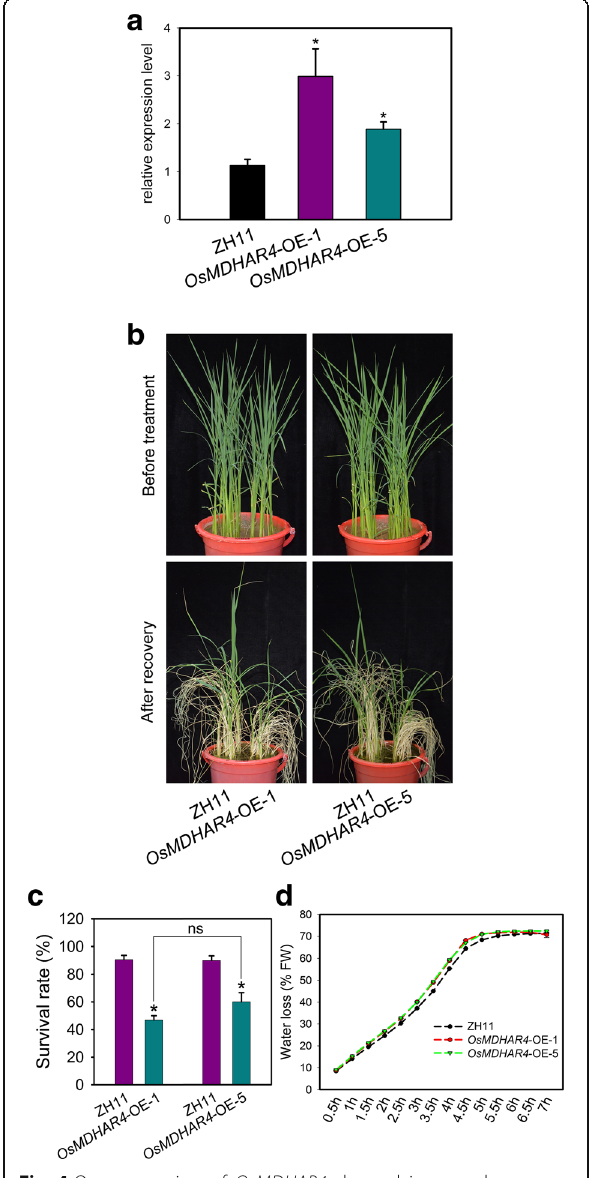
Fig. 4 Overexpression of OsMDHAR4 showed increased sensitivity to heat stress. a Transcript level of OsMDHAR4 was measured by qRT-PCR in two OsMDHAR4 -overexpresing lines ( OsMDHAR4 -OE-1 and OsMDHAR4 -OE-5, ZH11 background). The rice Actin1 gene was used as the internal control. Error bars indicate the SE based on three biological replicates.*, P < 0.05, by Student ’ s t -test. b 5.5- to 6.5-leaf stage ZH11 and OsMDHAR4 -overexpressing plants were subjected to 45 °C high temperature environment for 48 h, followed by growing in normal conditions for 7 d. Surviving seedlings were photographed. c Comparison of the survival rates of ZH11 and OsMDHAR4 -overexpressing plants after heat stress. Error bars indicated the SE based on three biological replicates. *, P < 0.05, by Student ’ s t -test. d Water loss from detached leaves of ZH11and OsMDHAR4 -overexpressing plants at indicated time points. FW, Fresh